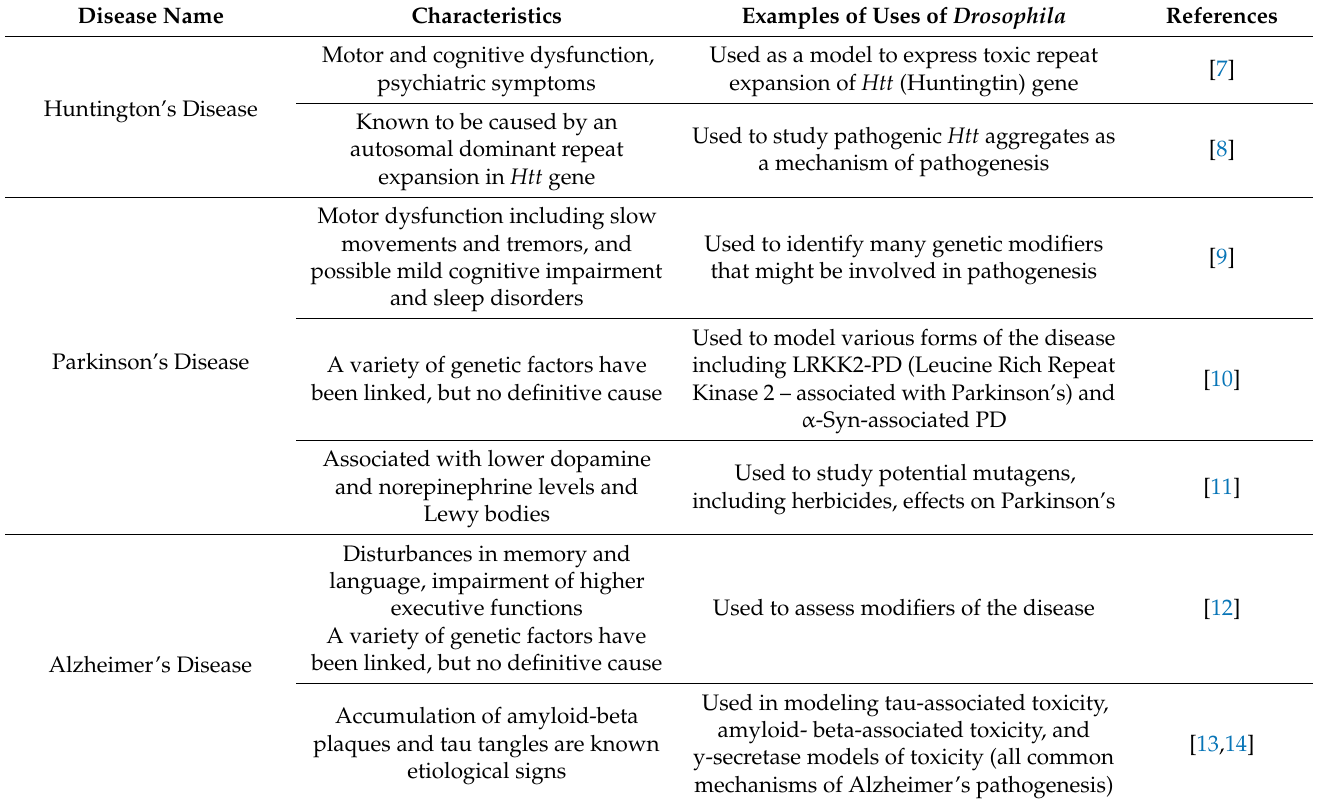
Table 1. Various neurodegenerative diseases with their physiological characteristics and the use of Drosophila in studying